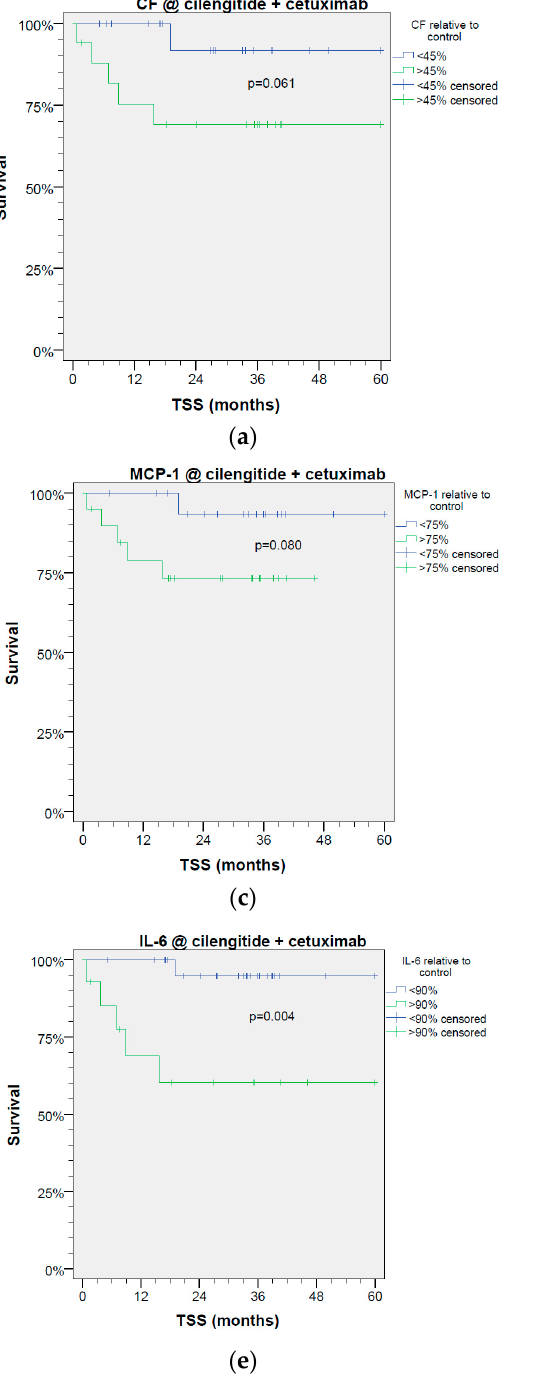
Figure 2. Colony formation of epithelial cells (CFec) and release of MCP-1 and IL-6 are prognostic factors for tumor-specific ( a , c , e ) and overall survival ( b , d , f ) of HNSCC patients. ( a , b ) Colony formation; ( c , d ) release of MCP-1, ( e , f ) release of IL-6 as optimized classifiers for survival derived from significant receiver-operating characteristic curves obtained from n = 39 HNSCC patients.